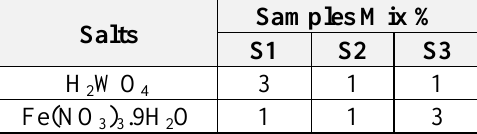
Table 1: Mixing percentages of salts.